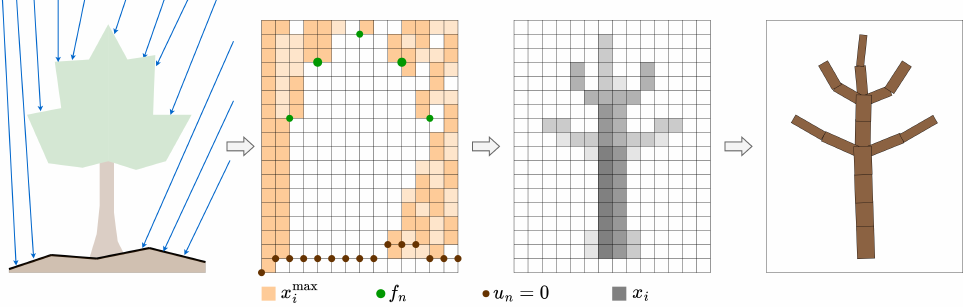
Figure 2. Two-dimensional depiction of our method. From left to right: ray cloud and ground mesh of a natural scene, optimiser constraints, optimiser output (per-voxel wood density), and BSG. The optimiser constraints are the Dirichlet condition (red dots), Neumann condition (green dots), and the maximum volume condition (white = 1, orange = 0) as defined in Equation